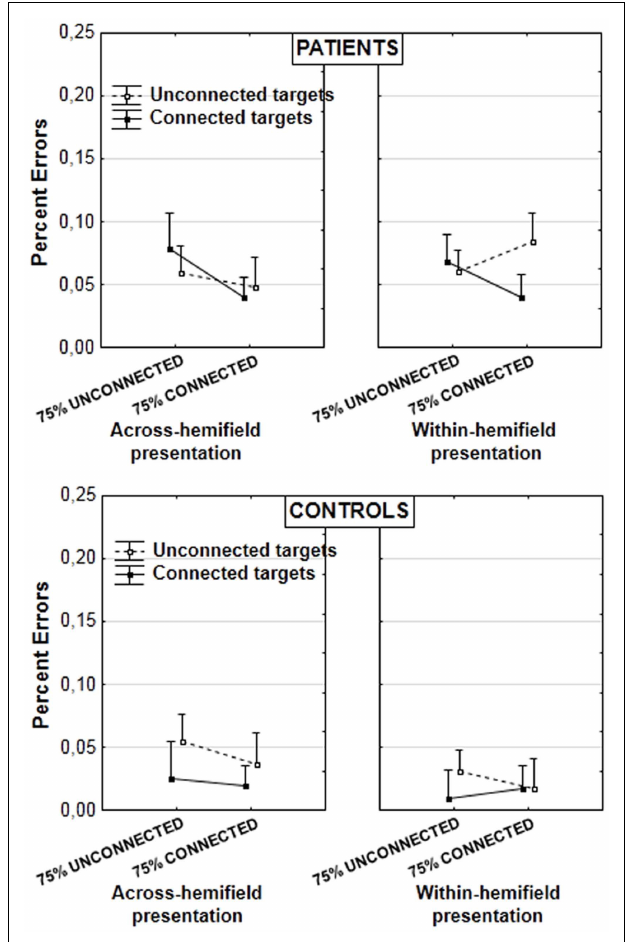
FIGURE 4 | Mean percent errors in patients (upper panel) and controls (lower panel; vertical bars: error bars). Results are illustrated according to the experimental blocks (with a bias toward unconnected vs. connected figures), type of target pair (unconnected vs. connected), and presentation of target pair (in the same or in different